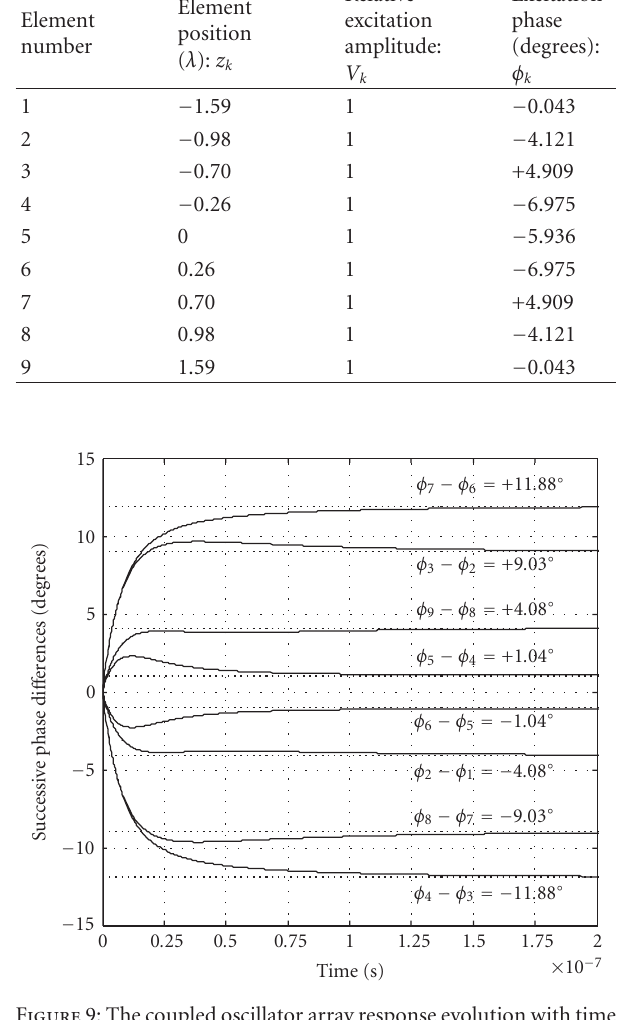
Figure 9: The coupled oscillator array response evolution with time for the constant amplitude design case. The evolution of the